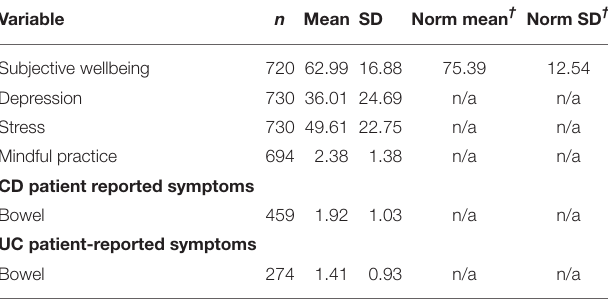
TABLE 2 | Means and standard deviations.